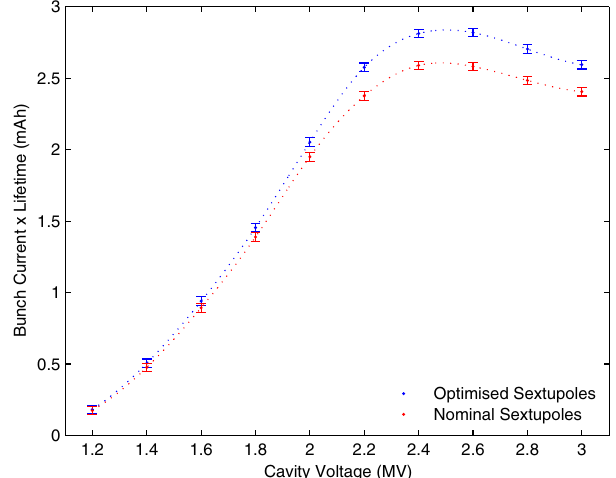
FIG. 12. Beam lifetime vs rf voltage after compensation of ν þ 2 ν ¼ 52 and 3 ν ¼ 82 . The red curve corresponds to the x y x data before the optimization reported in Fig.